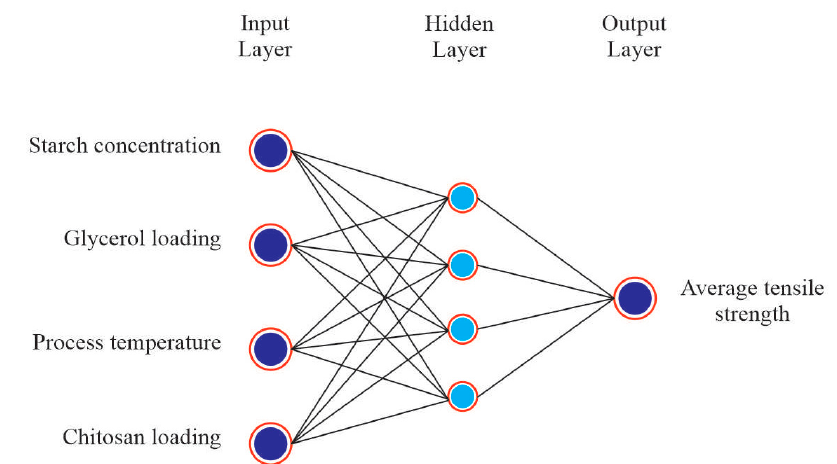
Figure 6. Architecture of ANN model for tensile strength.